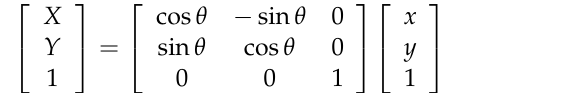
Figure 13. Tilt correction examples of “0” following the proposal ( left : original, right : tilt correction results).